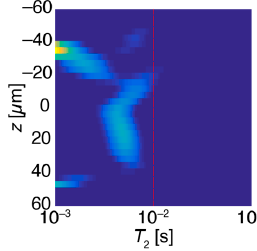
Figure 2. A z - T 2 map of a thick (~100 μ m) coating sample containing 1% triphenylphosphine (PPh 3 ). The top surface, exposed to the most intense UV irradiation, is more completely cured and shows greater crosslinking (smaller T 2 values). UV does not penetrate well into the lower regions of the sample (towards the positive z direction), as indicated by the larger T 2 relaxation times. Figure 3 highlights the correspondence between ATR-FTIR and T 2 measurements of crosslinking in the PEGDA network. The IR spectra are normalized to the peak at 1726 cm − 1 , corresponding to the acrylic carbonyl group; these carbonyl groups are largely unaffected during curing and their IR intensities should remain fixed. In contrast, the terminal CH=CH 2 bonds on the PEGDA monomers produce a peak at 1410 cm − 1 [17–20]. A decrease in the intensity of the 1410 cm − 1 peak when the sample is exposed to UV light indicates curing. Simultaneously, the measured T 2 value decreases after the sample has been exposed to UV irradiation. Crosslinking is associated with reduced T 2 values, as reported elsewhere [15].